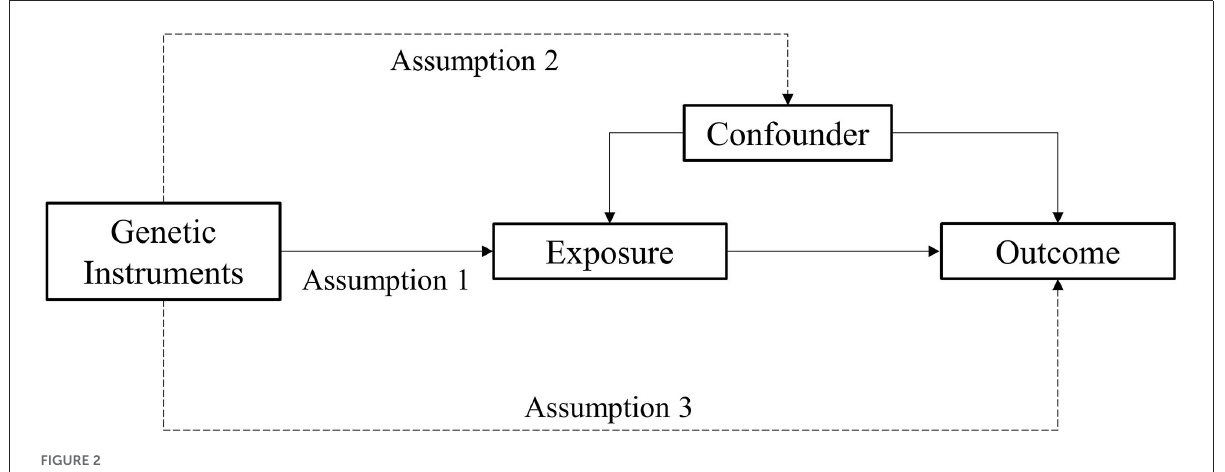
FIGURE2 Assumption of the Mendelian randomization